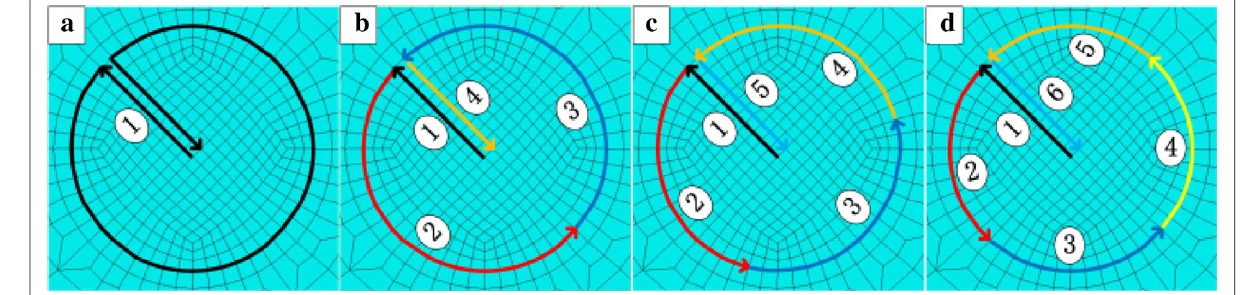
Figure 5 Schematic diagram of laser overlap welding method: a 1-section; b 2-sections; c 3-sections; d 4-sections